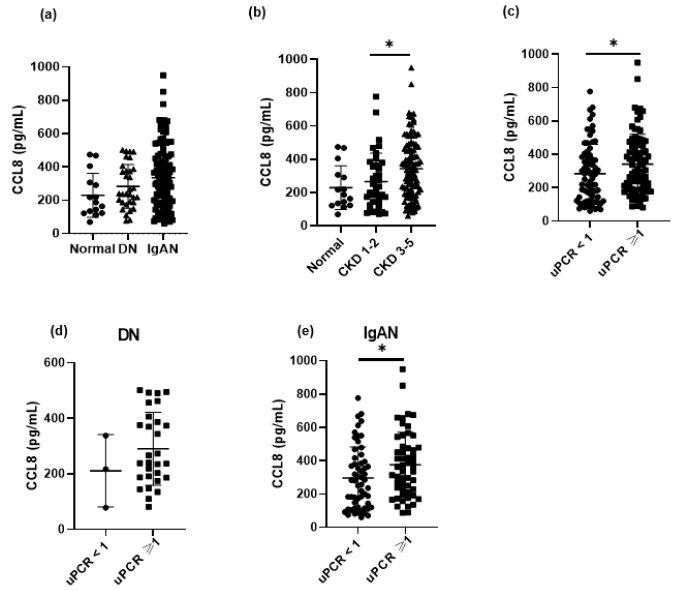
Figure 1. Serum CCL8 level were compared among patients with IgA nephropathy (IgAN, n = 110),